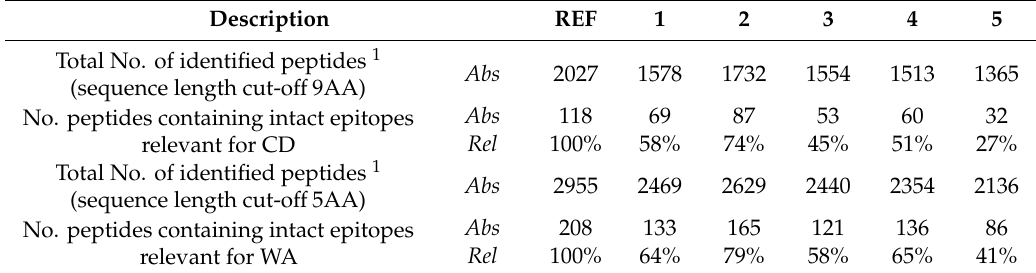
Table 3. Summary of the GD-resistant peptides identified at the end of the duodenal phase and counting of the peptides encrypting full length epitopes relevant for celiac disease (CD) and wheat allergy (WA).